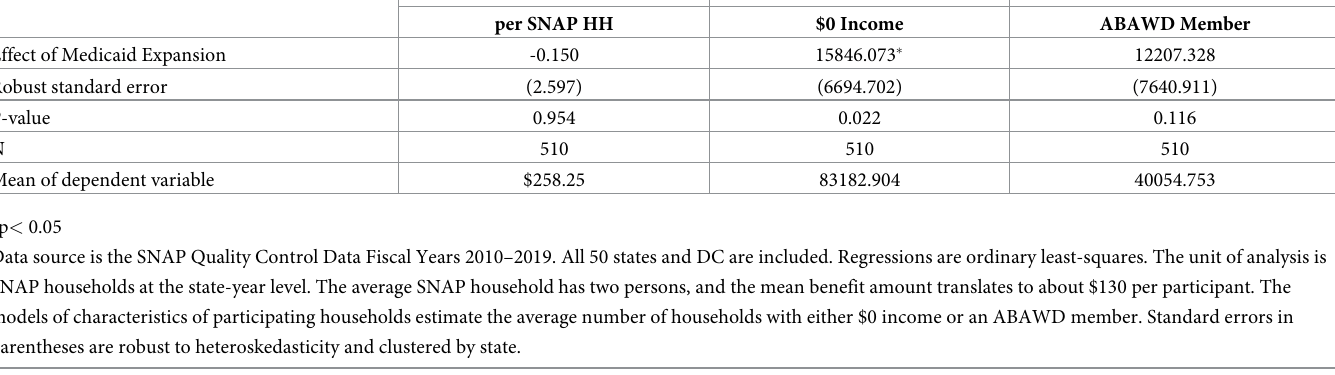
models of characteristics of participating households estimate the average number of households with either $0 income or an ABAWD member. Standard errors in parentheses are robust to heteroskedasticity and clustered by